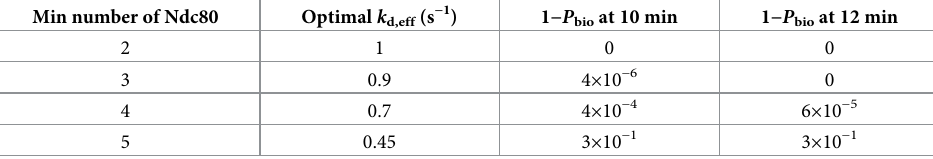
� As the minimum number of Ndc80s needed for biorientation increases, the error rate increases. Increasing the time needed for biorientation from 10 min to 12 min results in a significant drop in the error rate for the ‘4 Ndc80’ case, but no drop for the ‘5 Ndc80’